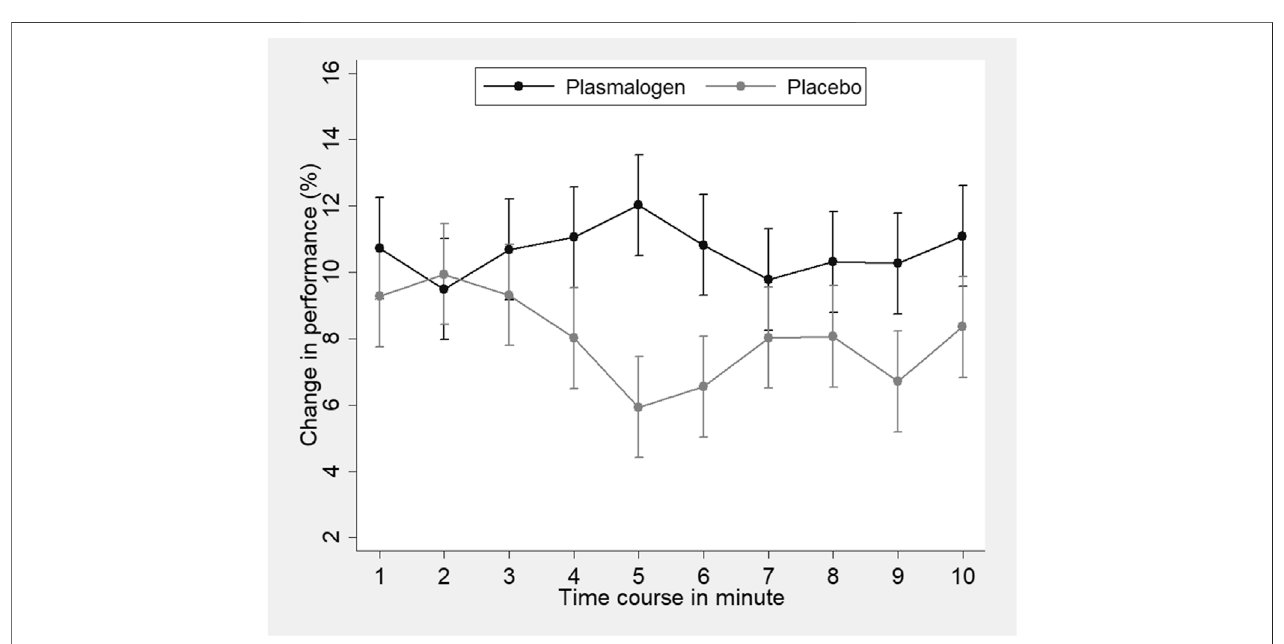
FIGURE 3 | Change in the Uchida-Kraepelin test performance according to time-course minutes of the task in plasmalogen and placebo groups. Based on repeatedmeasuresanalysisofvariancewithweeksoftreatment(2points) andelapsedminutes(10points)speci fi edasrepeatedmeasures.Verticalbarsrepresent95% con fi dence intervals of marginal means. Interaction for treatment and elapsed minutes was statistically signi fi cant ( p < 0.01, corrected by the Greenhouse-Geisser method).